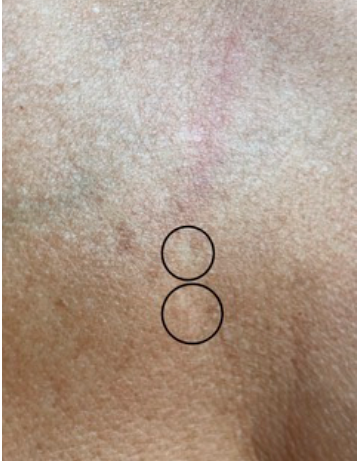
Figure 3. Slight scarring on the chest after laser therapy.